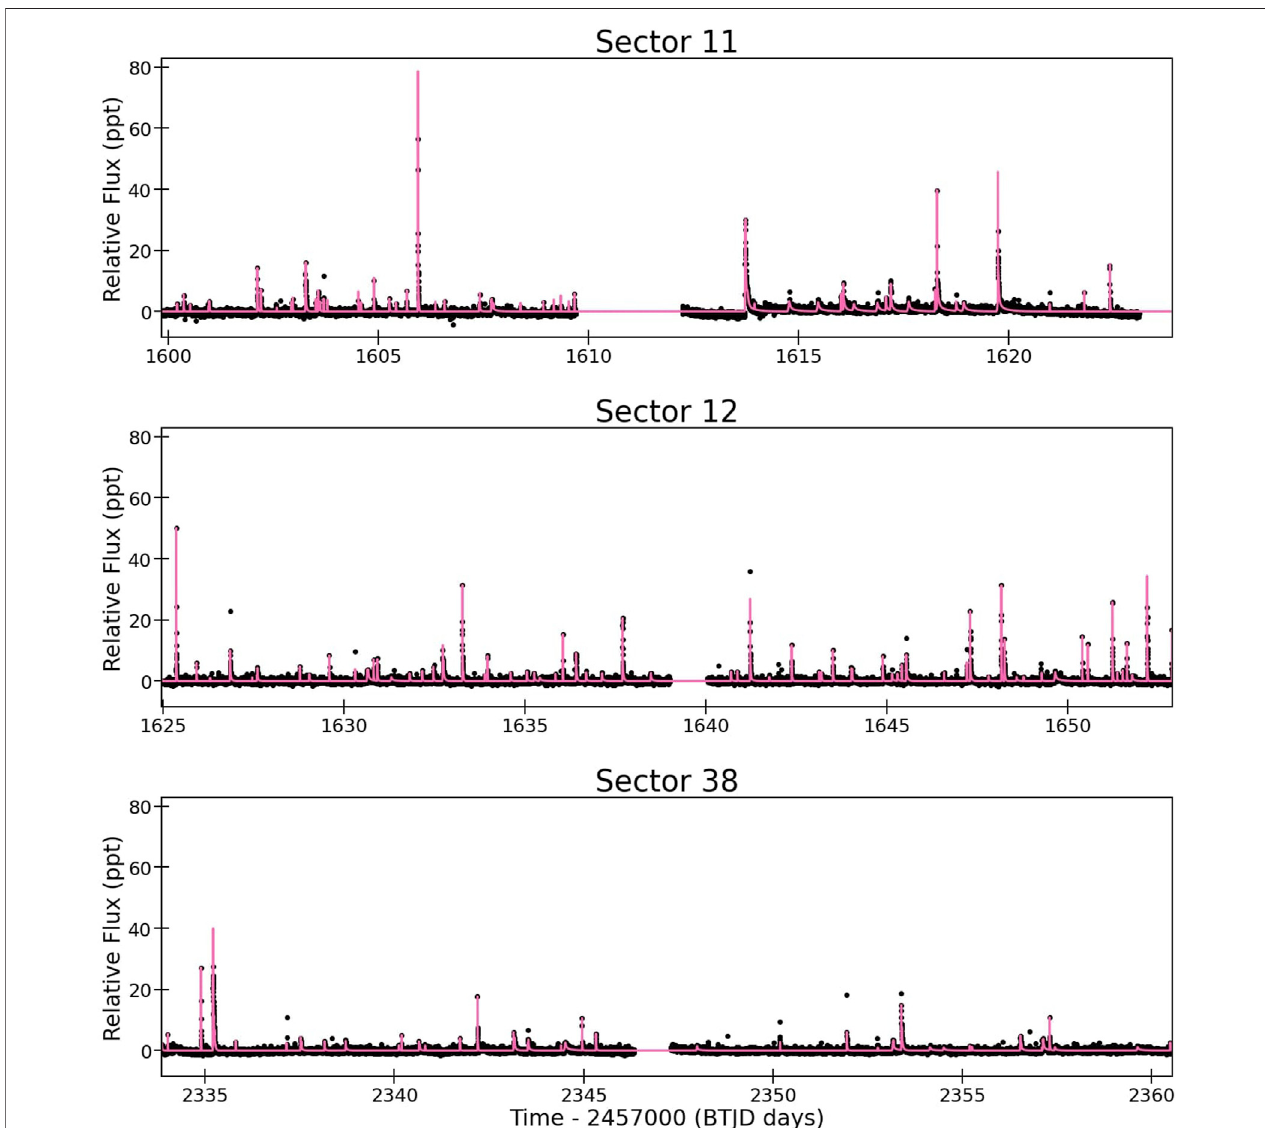
FIGURE 1 | Here we show the raw TESS light curves for each sector (black) with our fl are model overlaid (pink). By carefully modeling the fl ares and subtracting them off, we are able to conduct better transit searches in the data.